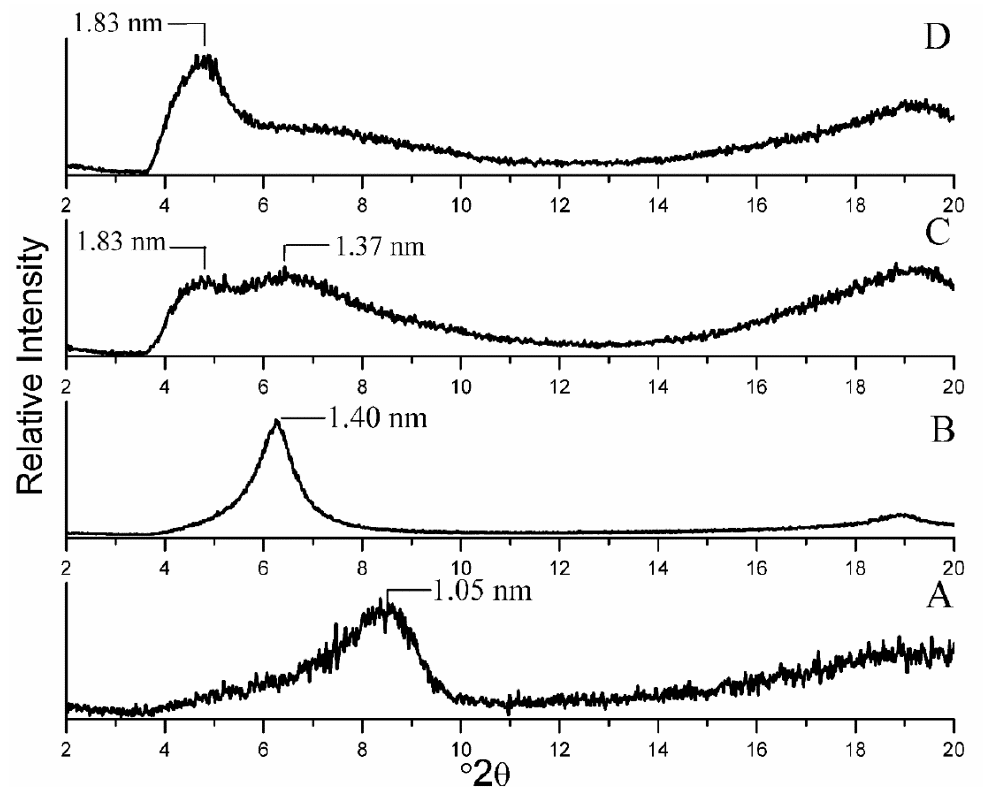
Figure 2. X-ray diffraction (XRD) patterns of ( A ) Na + mineral montmorillonite (MMT); ( B ) CG-MMT 3:1; ( C ) NG-MMT 3:1; ( D ) NG-MMT